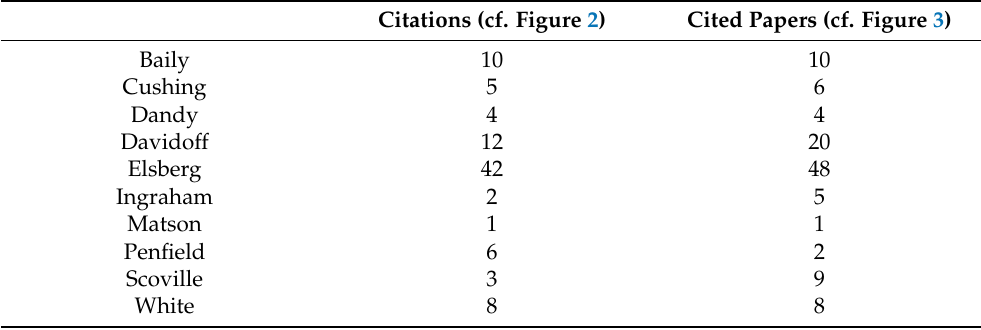
Table 5. Rankings of the u estimates for the ten most creative neurosurgeons as per Davis (1987). Citations (cf. Figure 2) Cited Papers (cf. Figure 3)